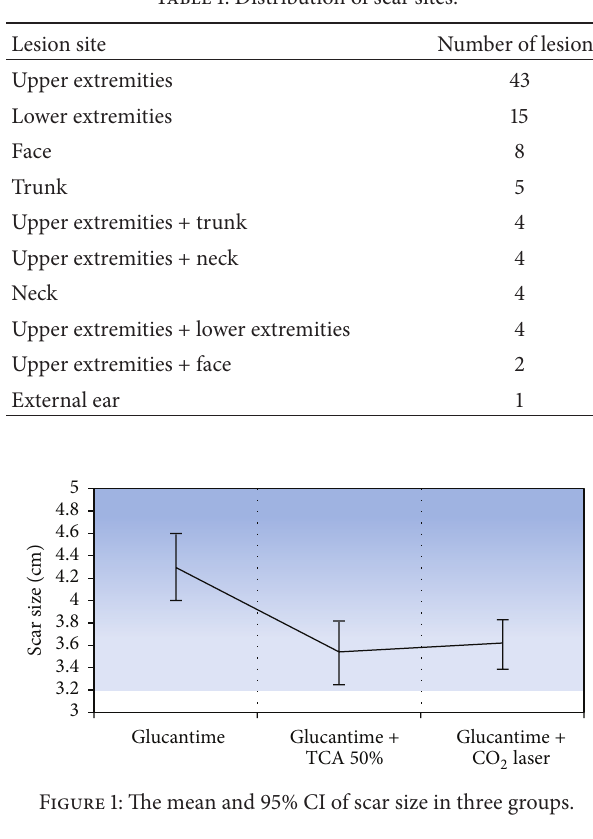
8 with triple lesions. The most common lesion types were nodule (48.9%) and plaques (35.6%). The three groups were similar in terms of age, sex, and number and location of lesions ( 𝑃 > 0.05 ). The most common lesion sites were the upper and lower extremities (Table